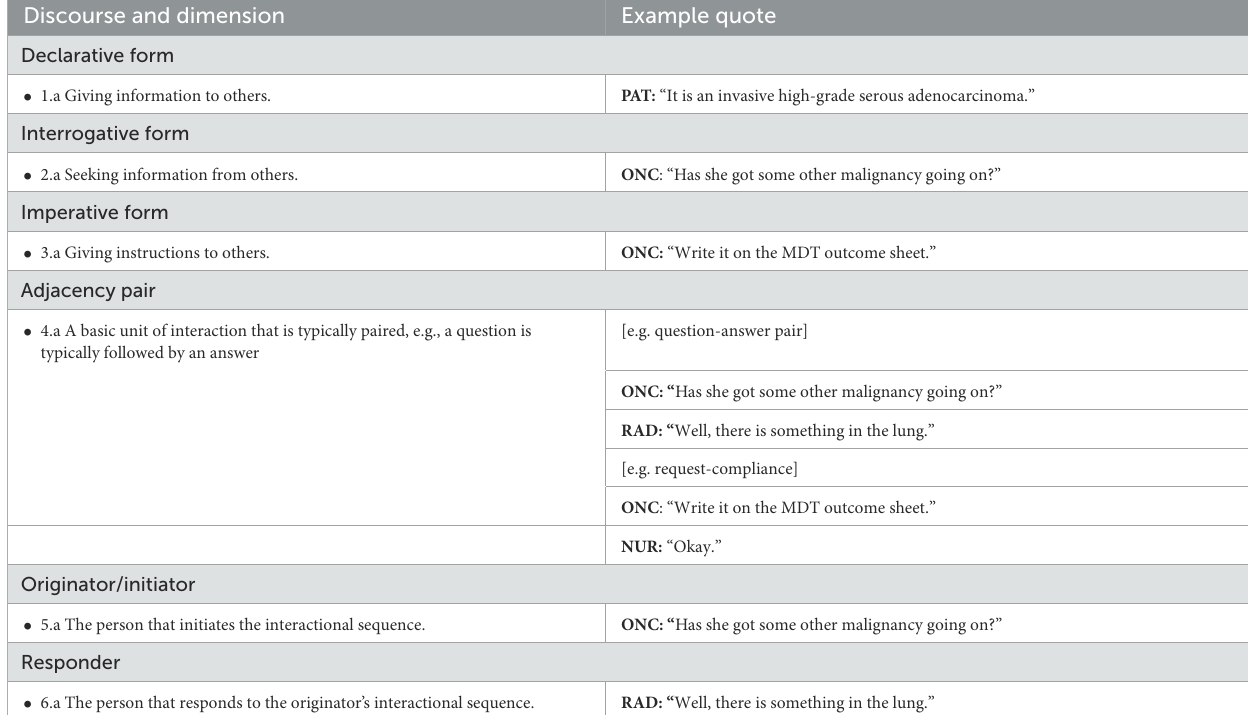
TABLE 2 Overview of terms used in the analysis of communication among participating cancer multidisciplinary teams (MDTs). Discourse and